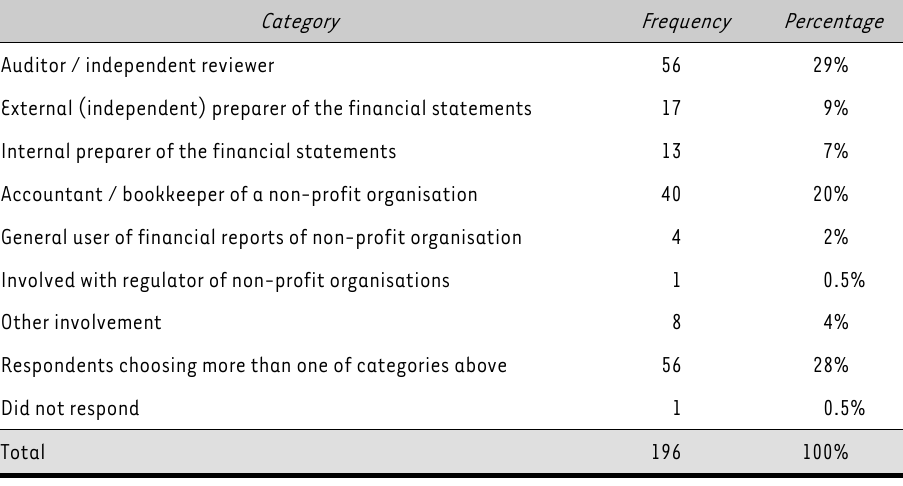
Categories of respondents' involvement in the financial reporting of non-profit